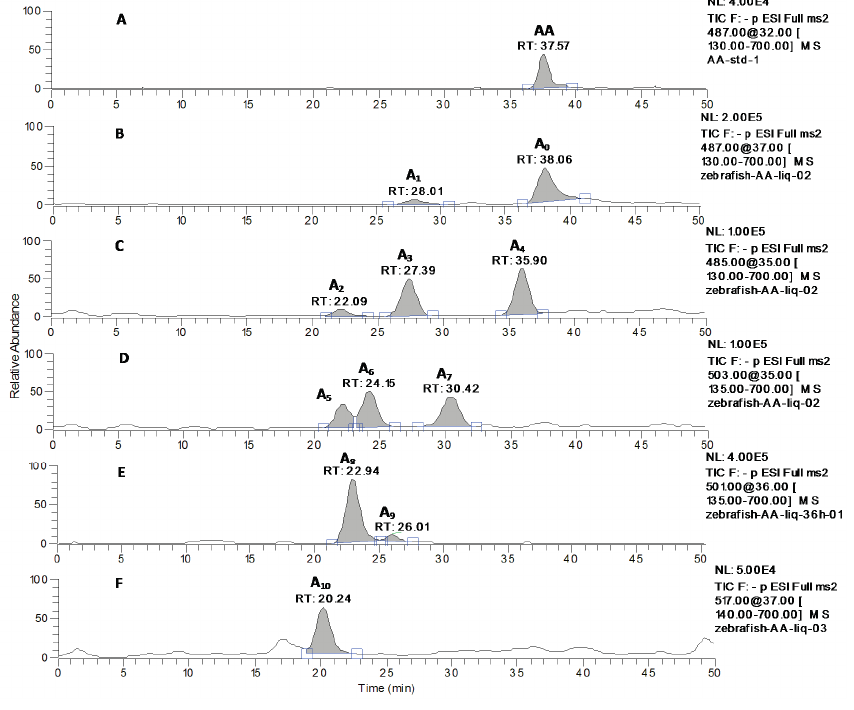
Figure 2. LC-MS/MS chromatograms of AA at m / z 487 ( A ) and its metabolites with zebrafish exposure at m / z 487 ( B ), m / z 485( C ), m / z 503 ( D ), m / z 501( E ), m / z 517( F